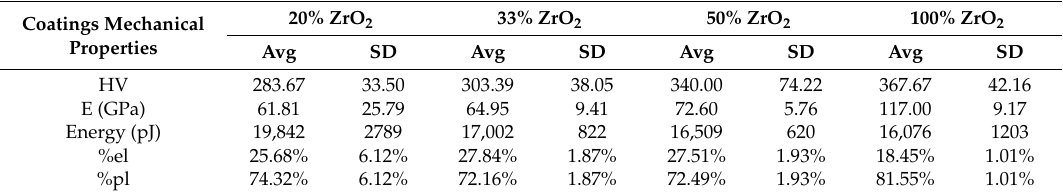
Table 2. Hardness of the coatings (HV), Young’s modulus (E), plastic work and percentages in the elastic (%el) or plastic (%pl) field, determined by nanoindentation as a function of ZrO 2 content (average values, Avg, and Standard deviations, SD, are reported)